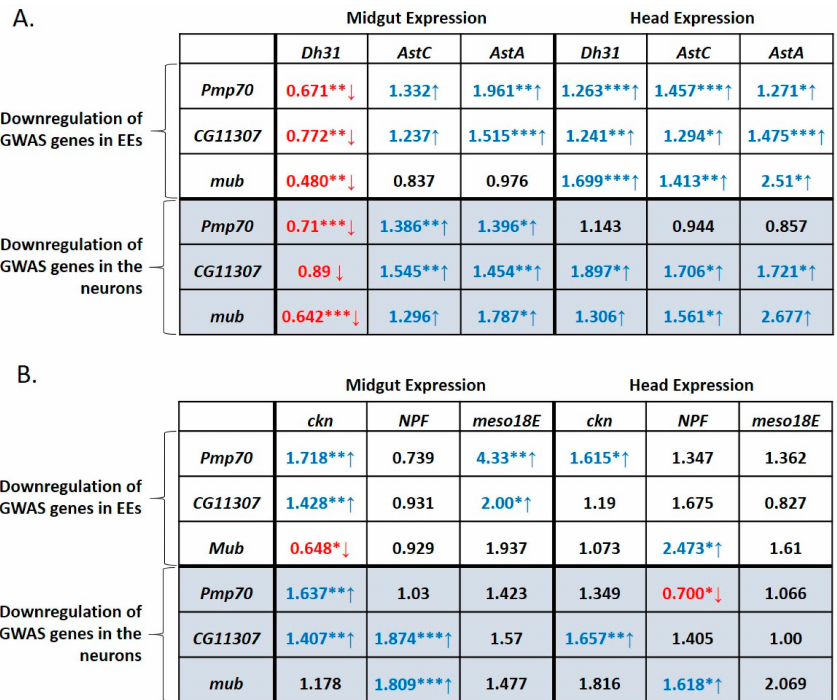
Figure 7. Downregulation of GWAS genes, mub , CG11307 and Pmp70 , in EEs or neurons consistently reduces Dh31 and increases AstC and AstA expression in the midgut, while Dh31 , AstC and AstA expression are all increased in the head. Relative expression levels of ( A ) hormone-encoding genes Dh31 , AstC and AstA and ( B ) GWAS-identified genes ckn , NPF and meso18E in the midgut and head of flies upon EE-specific (via prosV1-Gal4-UAS-RNAi) or pan-neuronal (via elav-Gal4-UAS-RNAi) downregulation of Pmp70 , mub or CG11307 , normalized to flies prepared from Gal4 lines crossed to w 1118 . Values in red font accompanied by a red arrow pointing down represent statistically significant decrease. Values in blue font accompanied by a blue arrow pointing up represent statistically significant increase. Each number represents the average of 12 values. Statistical analysis was performed using the t -test. Statistical significance indicated as * p < 0.05, ** p < 0.01 or *** p <